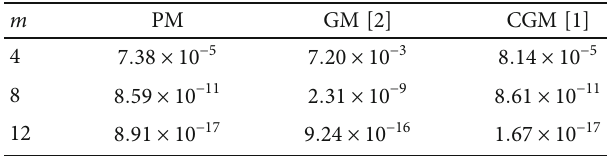
Figure 2: Approximate solution for Example 2 and its absolute Table 3: Maximum absolute errors for Example 3 at di ff erent degree of approximation m .